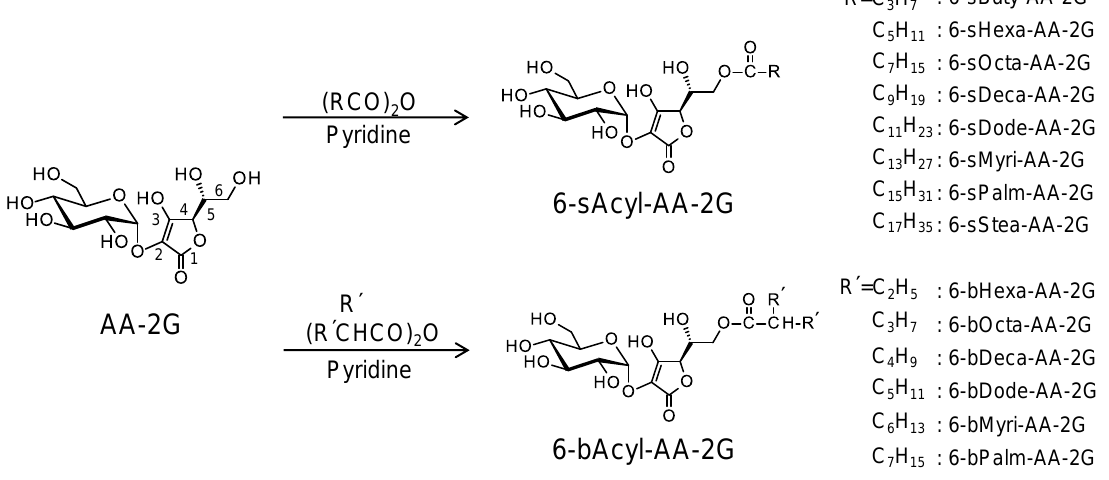
Figure 1. Structures of ascorbic acid (AA)-2G, 6-sAcyl-AA-2G and